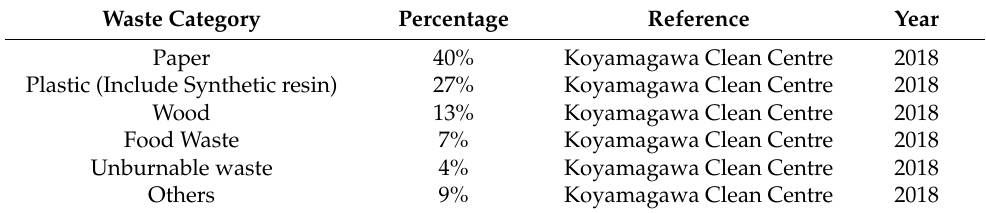
Table 1. Waste category and its